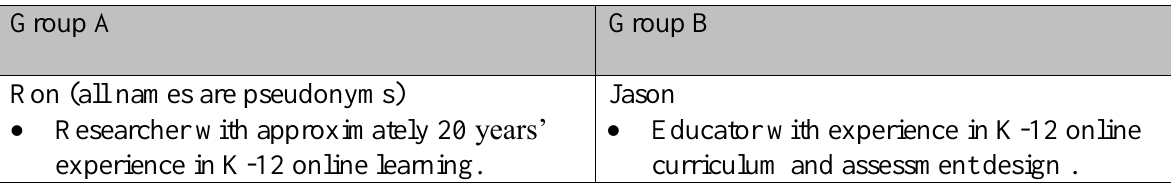
Description of the Two Expert Review